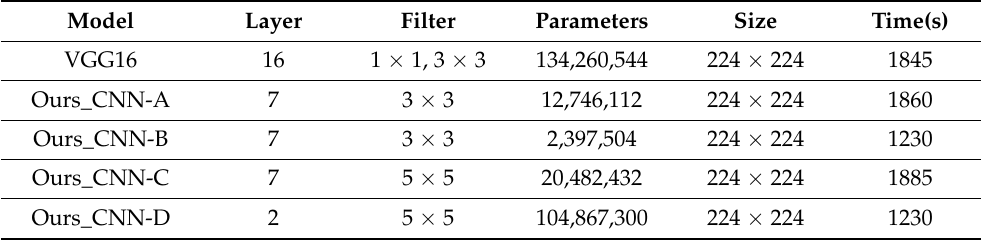
Table 1. Training parameter comparison. ADAM optimizer with lr = 0.0001, MaxPooling, ReLu activation, and 4096 flattened units employed for tuning